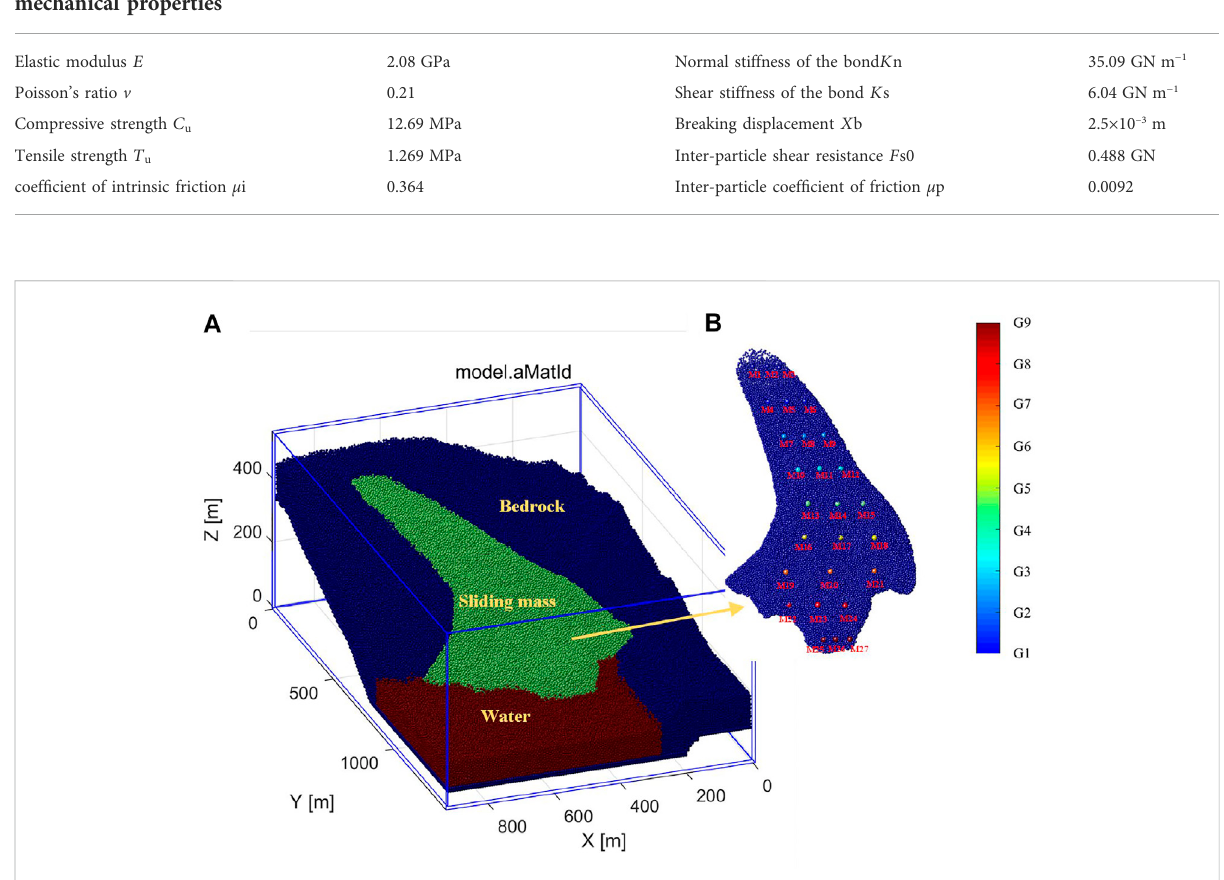
Figure 8A (the underwater terrain of the landslide was excluded). Water was set as a material without friction and strength to simulate the real material, and the force and softening effect of the water on the sliding mass were not considered. The discrete element method calculates the sliding speed of the landslide by considering the in fl uence of terrain factors, which is more suitable for real-world engineering situations. By cutting the sliding mass along the longitudinal direction, the closer it was to the landslide surface unit, the larger the velocity; therefore, this study divided the sliding mass material into nine regions (G1-G9). Three surface monitoring units were set equidistant from the right boundary to the left boundary of the sliding mass in each area, with a total of 27 (M1- M27) monitoring points, to monitor the speed of the front, middle, and rear parts of the sliding mass. To display the monitoring unit clearly, it is enlarged, and the original radius was used in the calculation, as shown in Figure 8B.